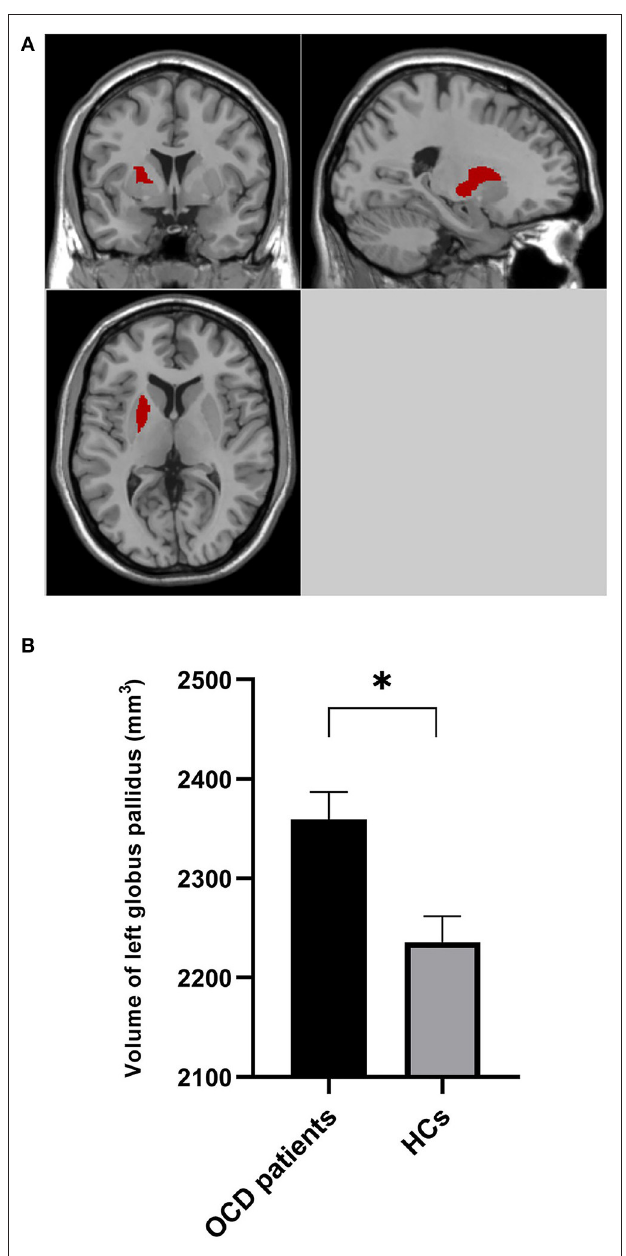
FIGURE 2 | Volume of left globus pallidus was bigger in OCD patients than HCs. (A) Left globus pallidus is shown in red. (B) The volume of left globus pallidus in OCD patients and HCs controlling for age and total supratentorial volume. * 0.01 < p < 0.05.